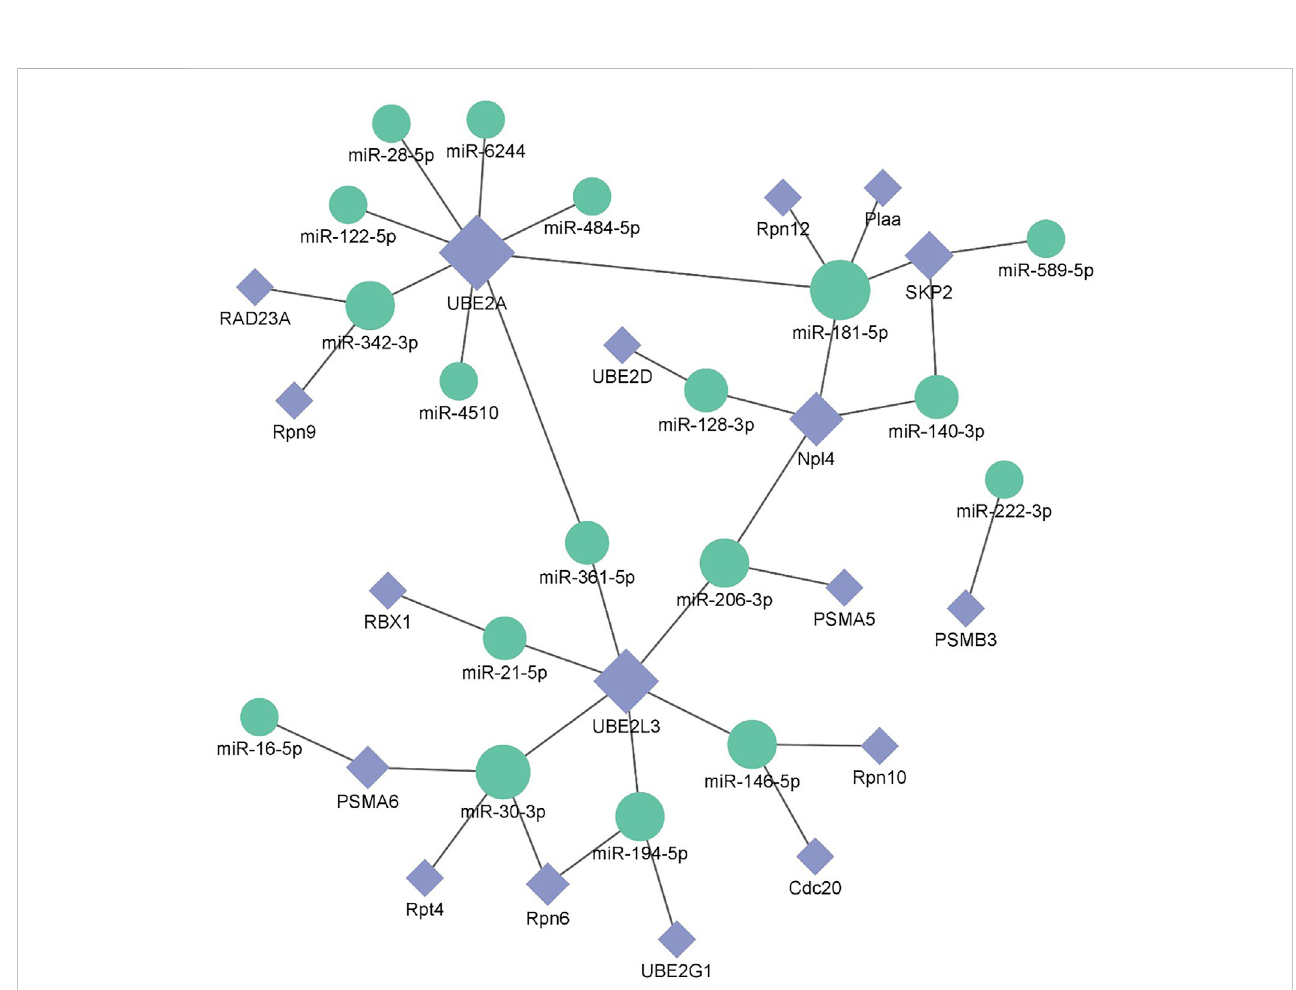
FIGURE 13 Potential miRNA-mRNA correlation network is related to the degradation of misfolded protein in